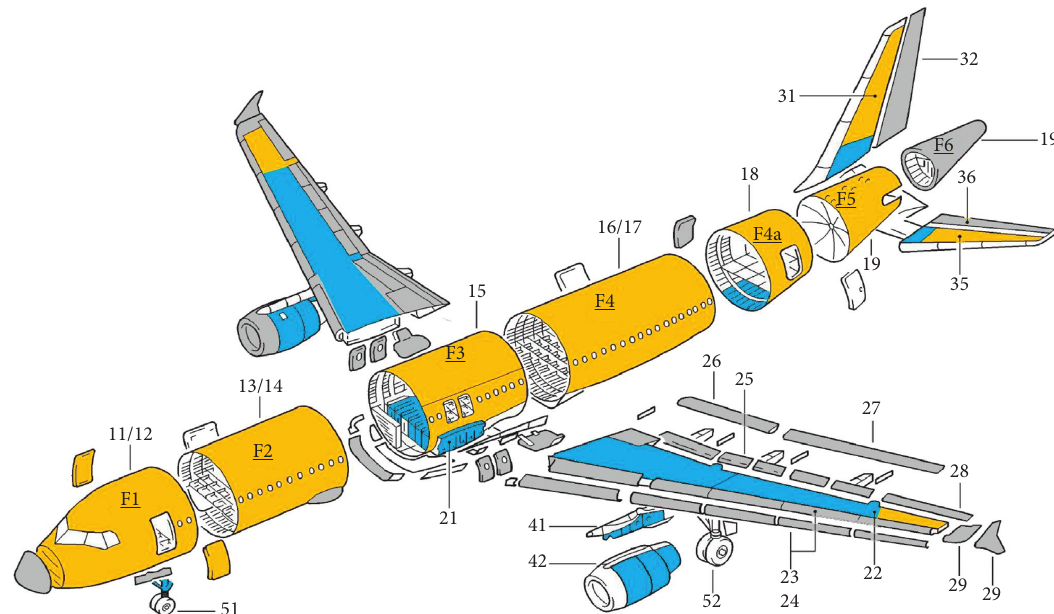
Figure 1: Structure of a typical large civilian